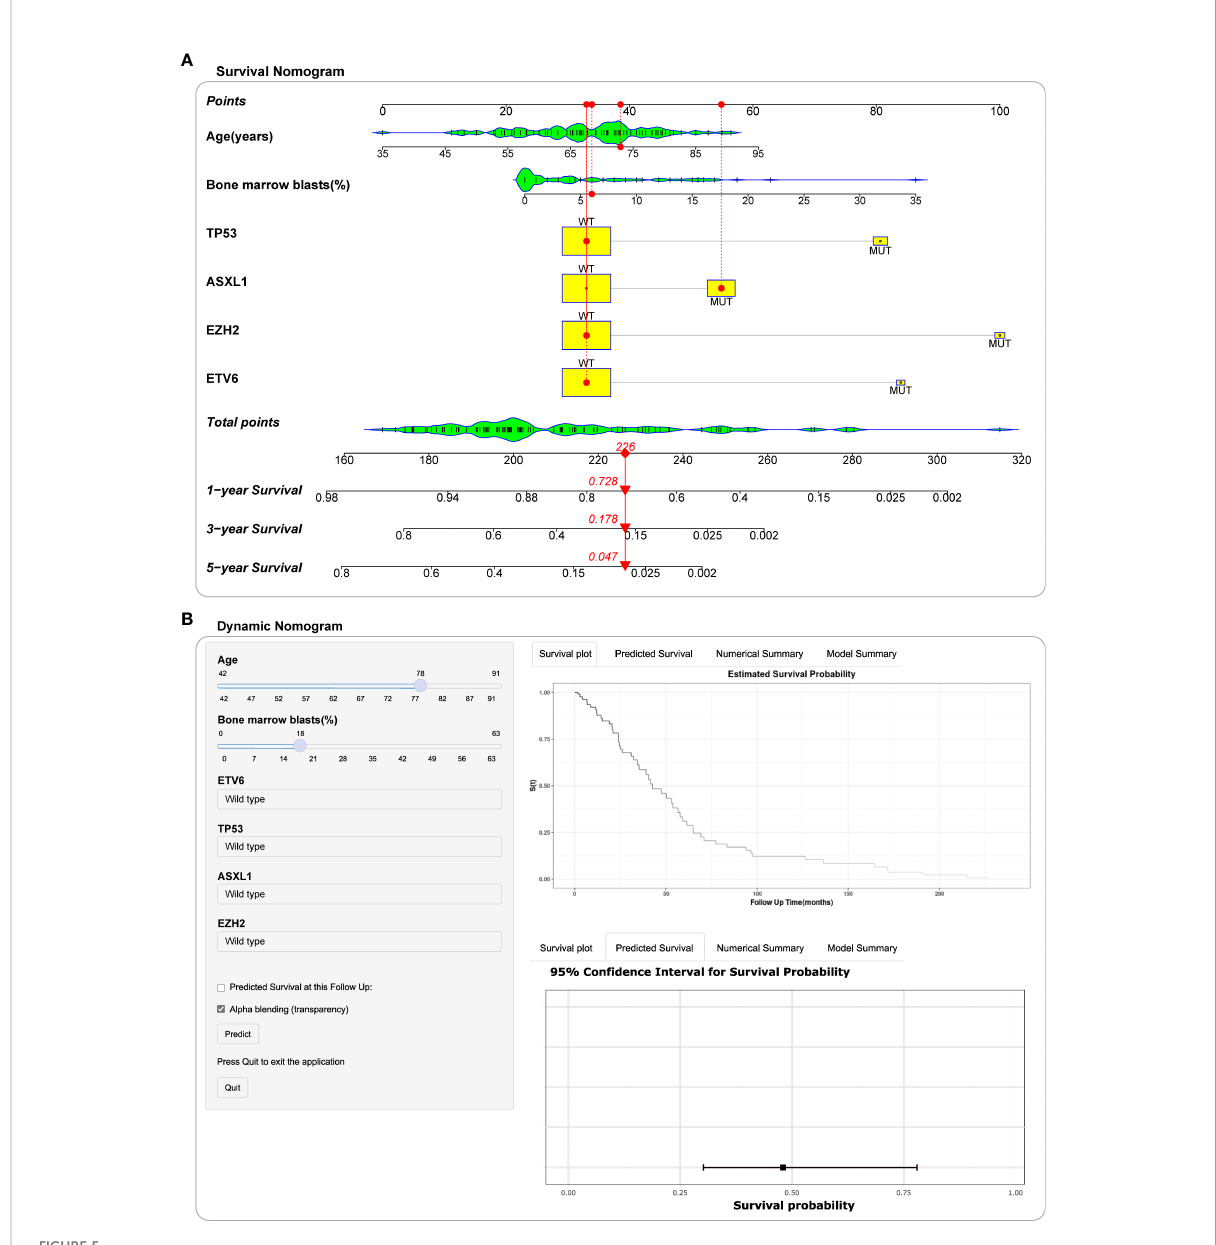
FIGURE 5 Construction of nomogram and dynamic nomogram. (A) Nomogram for predicted 1-year, 3-year and 5-year survival probability for MDS patients. A 73-year-old female patient had a bone marrow blast percentage of 6% with ASXL1 mutation and ETV6 mutation. According to the nomogram, the patient has a risk score of 226, which determines her survival probability of 1 year (72.8%), 3 years (17.8%) and 5 years (4.7%), respectively. (B) A dynamic Nomogram to predict the survival of MDS patients in Shinyapps